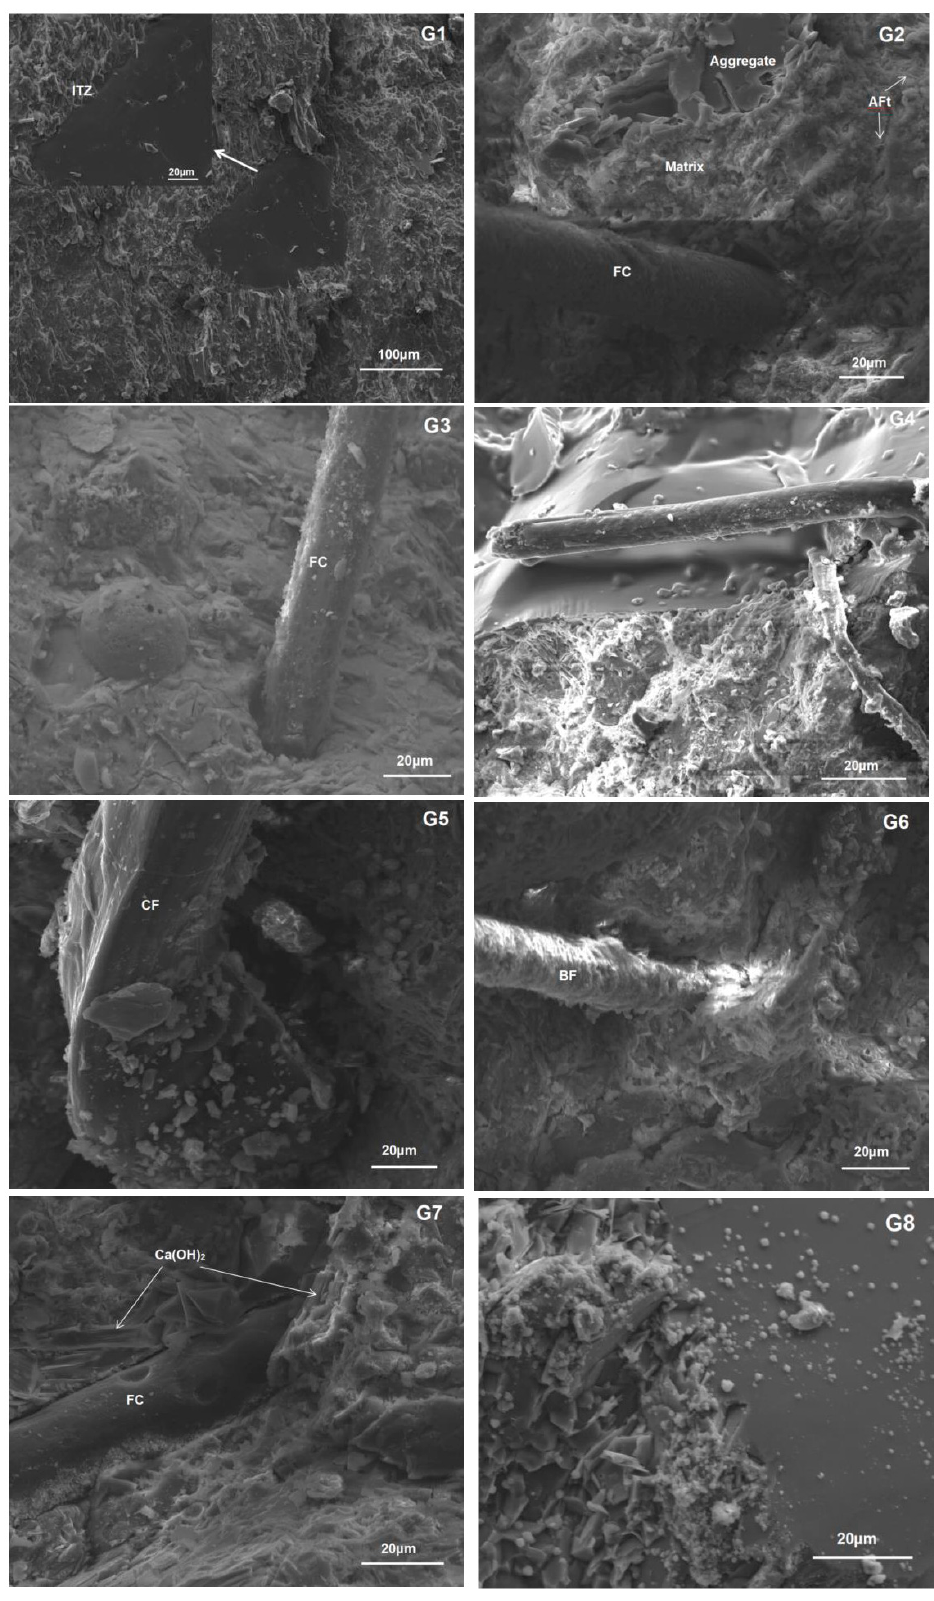
Figure 12. Electron microscope pictures of 8 groups of concrete.